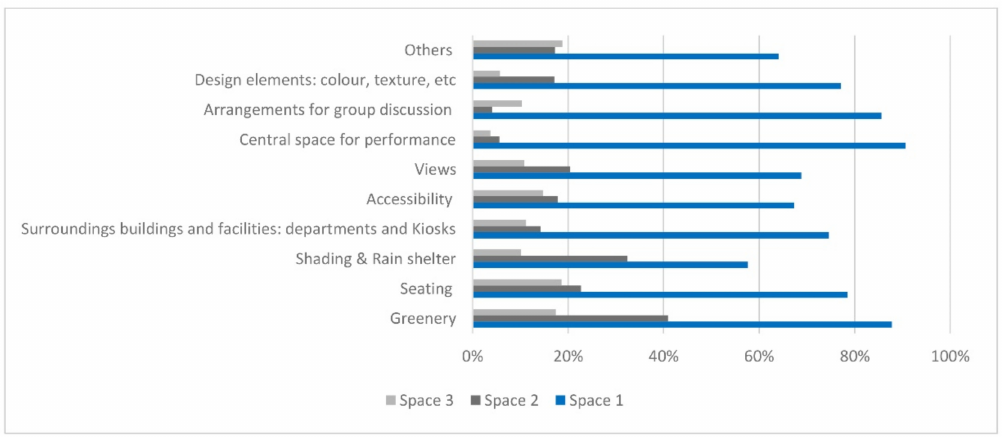
Figure 14. Respondents’ opinions about the physical features of the open